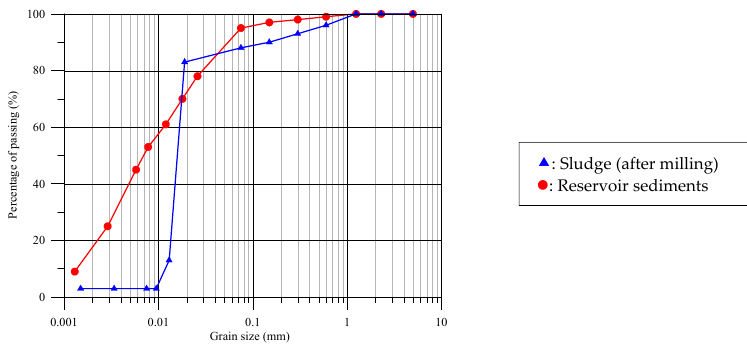
Figure 1. Grain size distributions of sludge and reservoir sediments. Table 3. Physical test results of sludge and reservoir sediments.